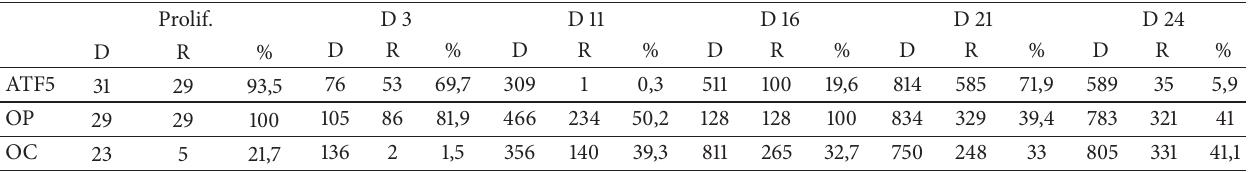
Table 1: Number and percentage of positive cells for ATF5, OP, and OC. Percentages of positive cells were calculated on the total amount of DAPI for each image (Figure 3).